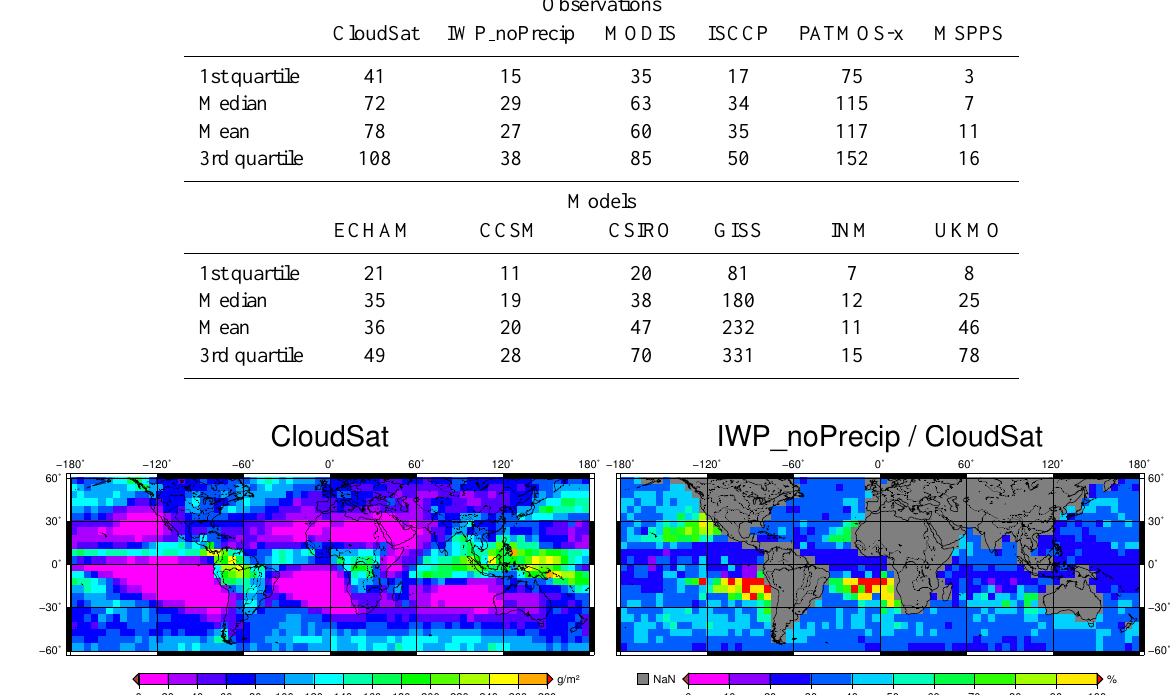
Table 3. Quartile values of the cumulative distribution of gridded IWP data, and the total mean as shown in Figs. 5 and 6. All datasets and statistics are based on a 5 ◦ grid, and the unit for IWP is g / m 2 . Observations